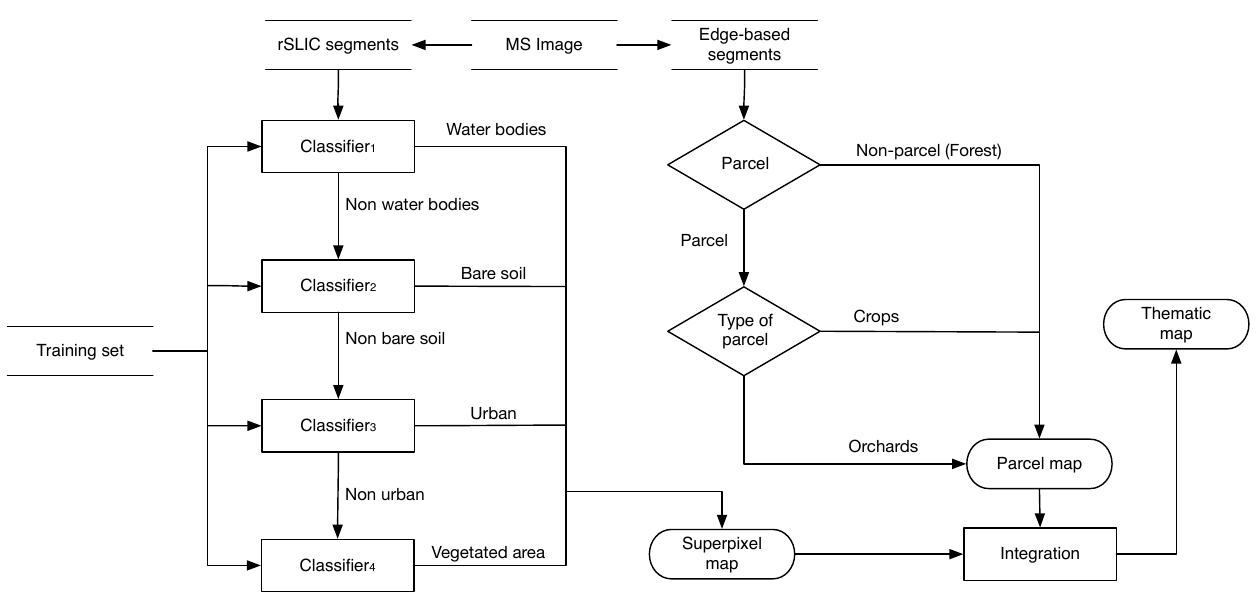
Figure 4. Workflow of the analysis process. Two classifications are carried out